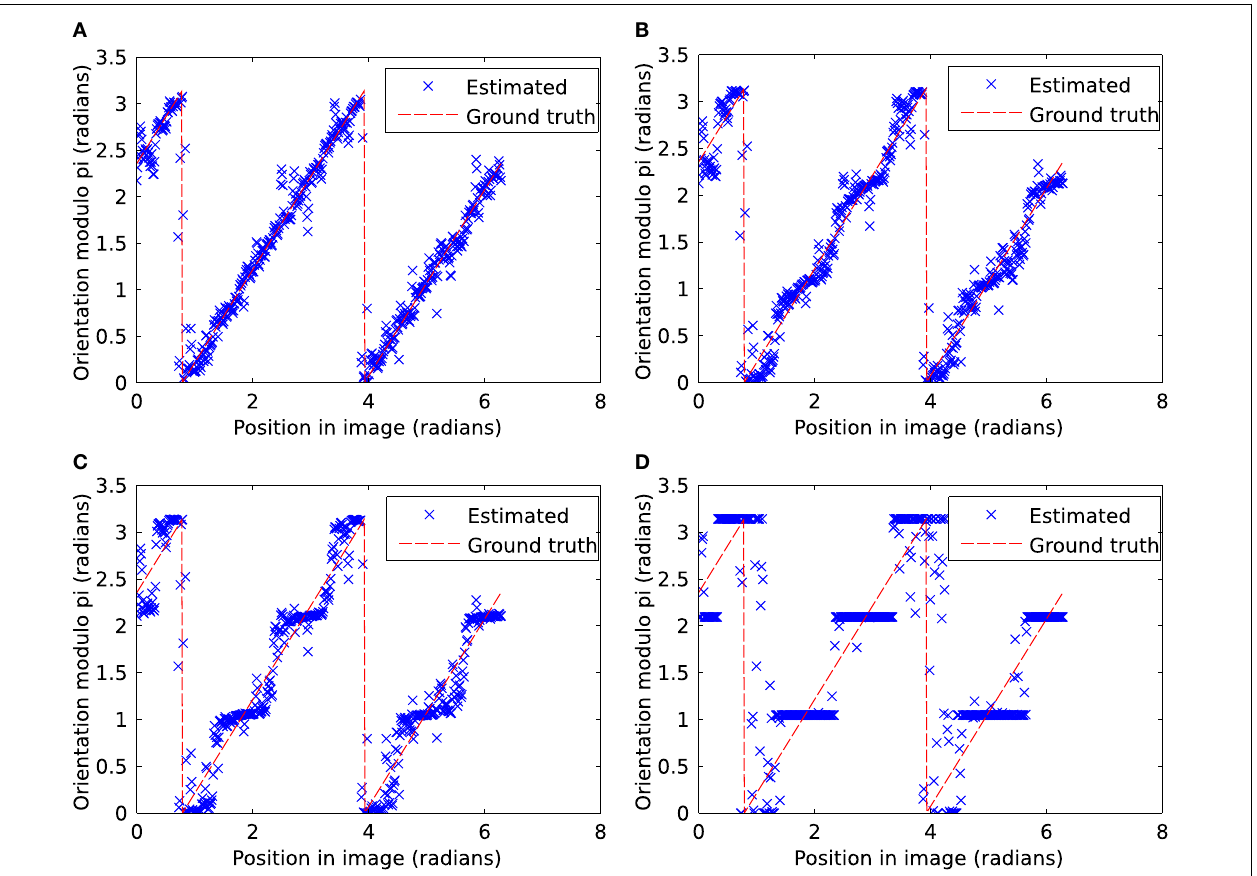
FIGURE 12 | Evaluation results using stimuli from Figure 10 for three channels . (A–D) decoding with respectively 0, 5, 10, and 100 iterations according to